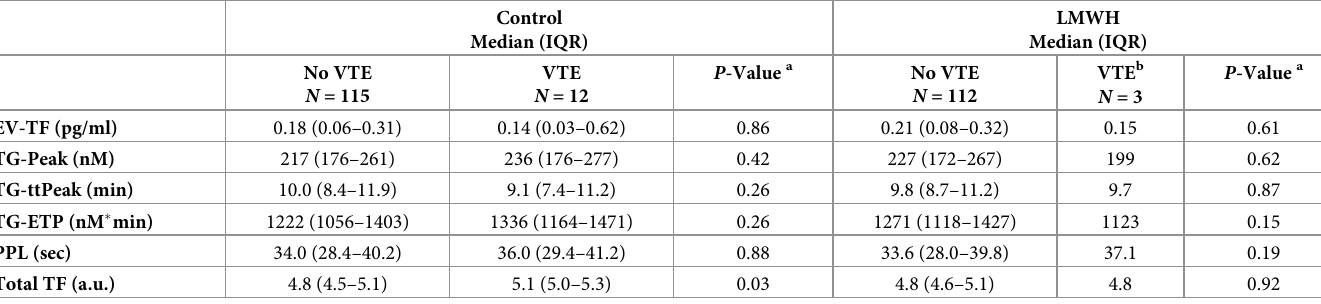
IQR = Interquartile range; VTE = Venous thromboembolism.; EV-TF = Tissue factor associated with extracellular vesicles; TG = Thrombin generation; ttPeak = Time to peak; ETP = Endogenous thrombin potential; PPL = Phospholipids; TF = Tissue factor; a.u. = Arbitrary units a Comparison of biomarker levels based on VTE incidence using Mann-Whitney test. b Due to the limited number of patients in this subgroup data on IQR is not available. https://doi.org/10.1371/journal.pone.0207387.t003 trial population, none of the TG parameters predicted VTE risk. These inconsistencies may relate to insufficient standardization of the assays used, but probably also reflect the complexity of the coagulation system in malignancy, e . g . it remains unclear how key regulatory factors, including antithrombin and tissue factor pathway inhibitor-1, either soluble or EV-associated, contribute to the overall coagulation status in cancer patients.